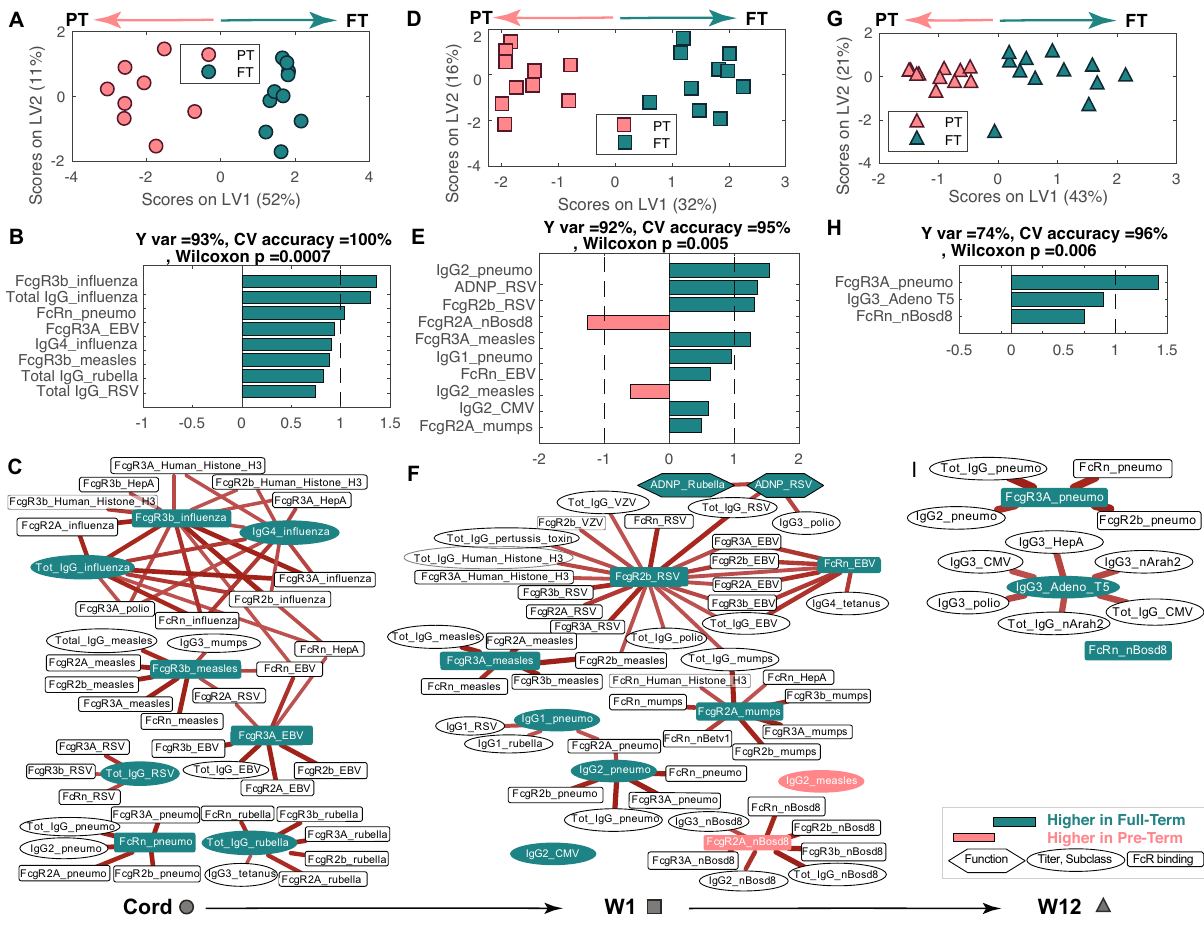
Figure 4. Antigen-specific antibody differences across gestational ages normalize over time but may point to immune vulnerabilities. ( A ) OPLSDA shows the separation between PT (PT:pink) and FT (FT:green) cord blood. Each dot represents an individual sample. The orthogonalized approach ensured that Latent Variable 1 (LV1) captured the separation between PT and FT antibody profiles while simultaneously capturing 93% of the Y-variation, while LV2 captured the antibody profile variances that do not contribute to this separation. fivefold cross validation was performed, resulting in 100% Cross Validation (CV) accuracy. Permutation test was performed by randomly shuffling the labels. Our model performed significantly better than random (Wilcoxon p = 0.0007). ( B ) The ordered VIP scores on LV1 for all the LASSO selected features are directed (and colored) based on whether the features are enriched in FT (green, right) or PT (pink, left) infants. ( C ) The network represents antibody features that are highly correlated with the LASSO-selected features across cord samples. ( D , E ) OPLSDA model shows the differences in antibody profiles between PT and FT infants at week 1, resulting in 95% CV accuracy and permutation test Wilcoxon p = 0.005. LV1 captured the separation of PT and FT, 92% of the Y-variation. Bar graph shows VIP scores for loadings on LV1 similar to ( B ). ( F ) The network represents features that are highly correlated with the LASSO-selected features across week 1 samples. ( G , H ) OPLSDA model separates PT and FT 12-week infants, resulting in 92% CV accuracy and permutation test Wilcoxon p = 0.006. LV1 captured 74% of Y-variation. The VIP scores plot highlights fewer differences between the groups. ( I ) The network represents antibody features that are highly correlated with the LASSO-selected features across 12-week infants. In networks of ( C ), ( F ), ( I ), edges depict correlation coefficients after removing correlation coefficients < 0.7 and p-values > 0.05 (corrected for multiple comparisons using Benjamini-Hochberg method). The red color of the edges represents positive